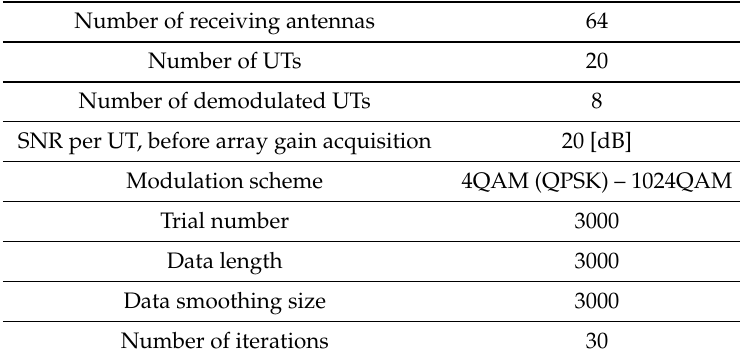
Table 1. Simulation conditions.